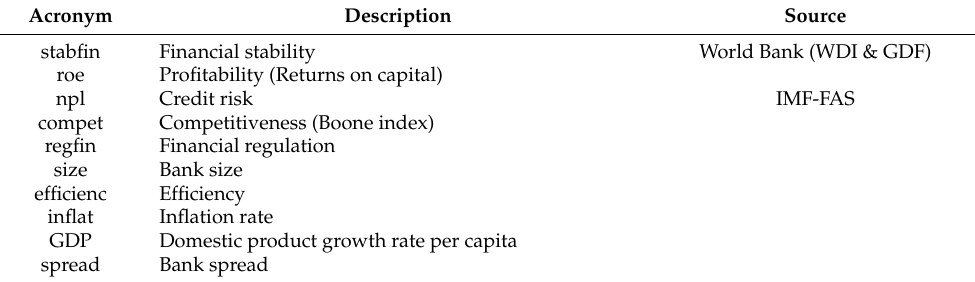
Table 2. Bank-specific variables and macroeconomic